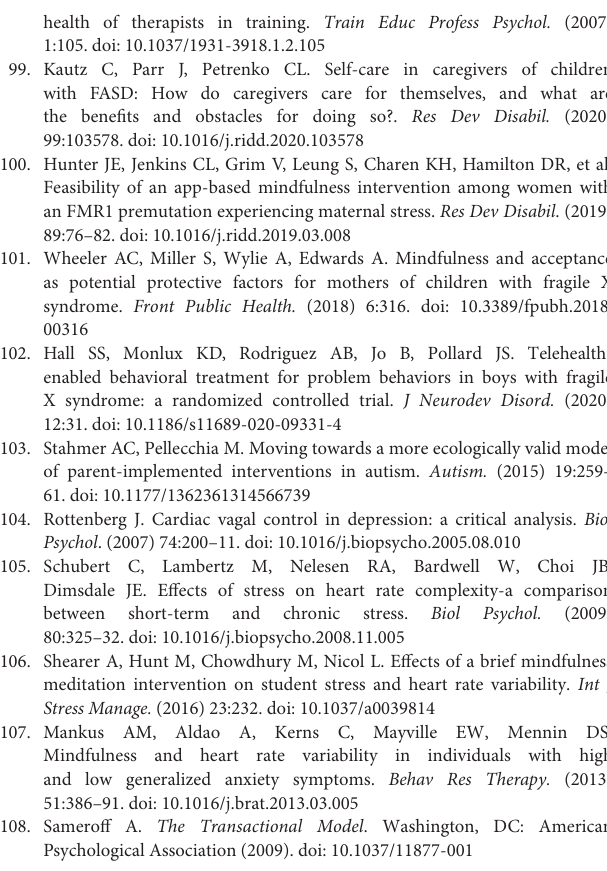
Table 2: 12-month prevalence DSM-IV/WMH-CIDI disorders by sex and cohort (accessed August 21, 2017). 89. Agorastos A, Stiedl O, Heinig A, Sommer A, Hager T, Freundlieb N, et al. Inverse autonomic stress reactivity in depressed patients with